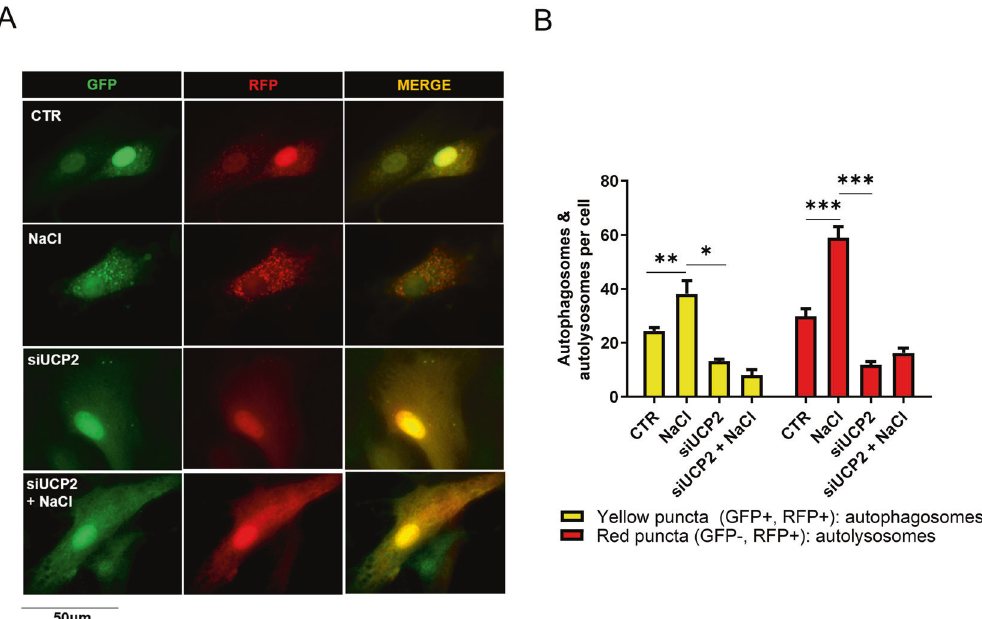
Fig. 4 Autophagic fl ux evaluation by the mRFP-GFP-LC3 tandem probe in UCP2-silenced cells exposed to high-salt. A , B High-salt treated siUCP2 microvascular brain endothelial cells were transduced with adenovirus overexpressing mRFP-GFP-LC3 to evaluate LC3 puncta. Yellow dots (merged red and green) indicate autophagosomes whereas red dots indicate autolysosomes. Representative images ( A ) and corresponding quanti fi cation ( B ). ( N = 5). * p < 0.05, ** p < 0.01, *** p < 0.001 obtained using the one-way ANOVA followed by Bonferroni post hoc analysis. Data are reported as mean ±